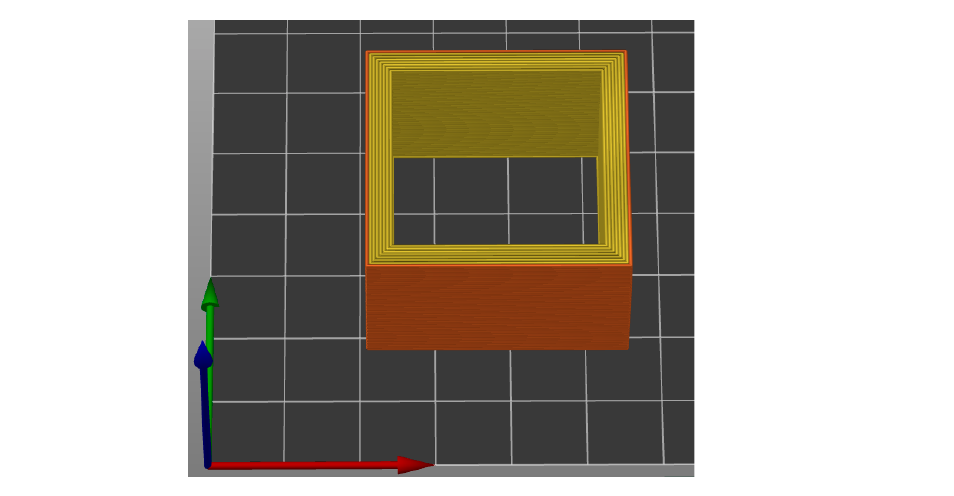
Figure 6. Animated G-code of the square box green part (35 mm × 35 mm × 20 mm (l × w × h)). Two planes in different z-heights were considered (Figure 7 left). The two contours were then superimposed normally to each other to visualize the twisting of the square contour (Figure 7 right). Only one representative corner of the square was analyzed in the following, Figures 7–9.